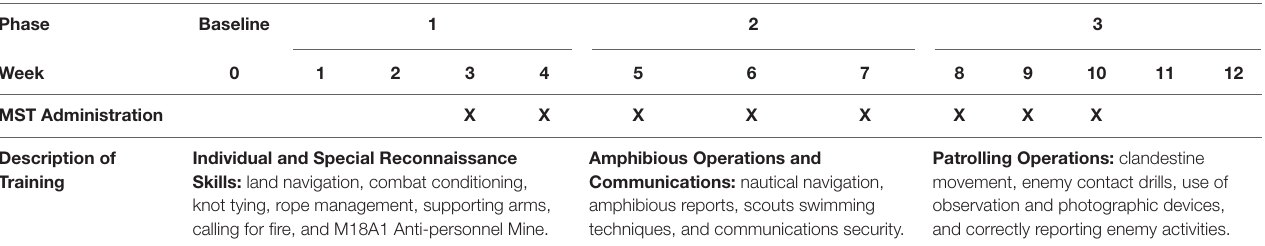
TABLE 1 | Overview of Marine Corps’ Basic Reconnaissance Course Training Paradigm.